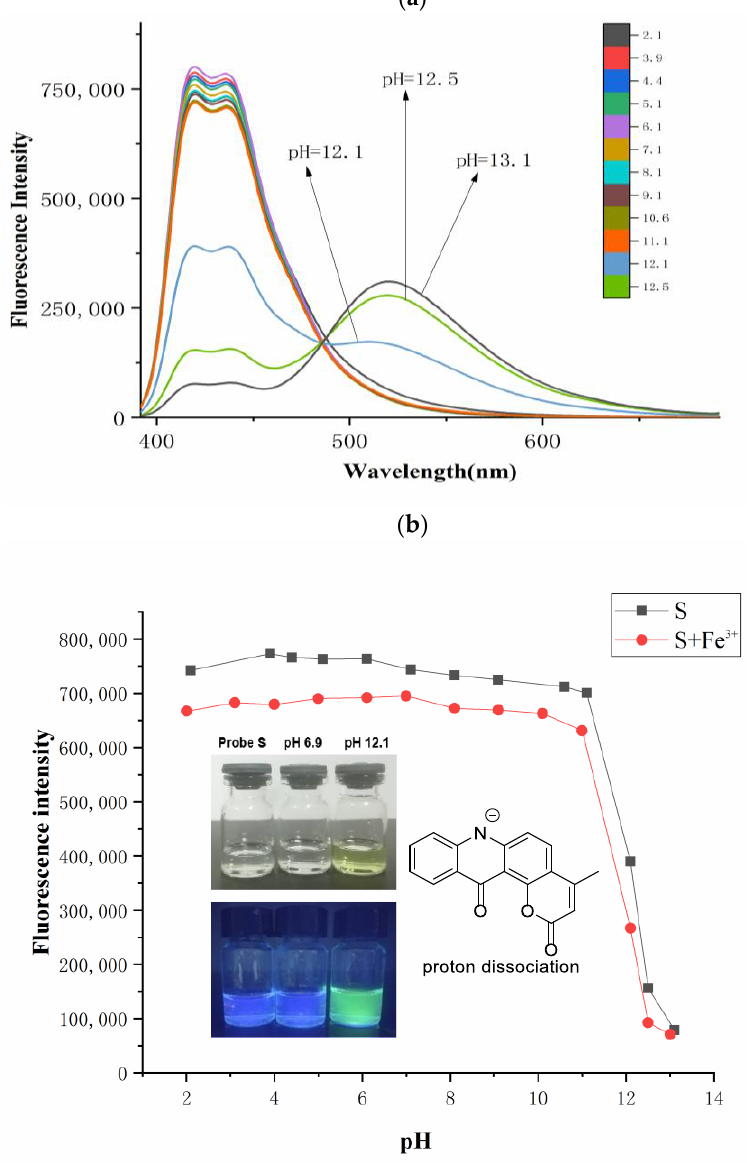
Figure 8. ( a ) The fluorescence response of probe S (20.0 µ M) to Fe 3+ (10.0 mM) at different pH values. ( b ) Fluorescence intensity of probe S (20.0 µ M) at various pH values ( λ em = 420 nm) in the absence and presence of Fe 3+ (10.0 mM).